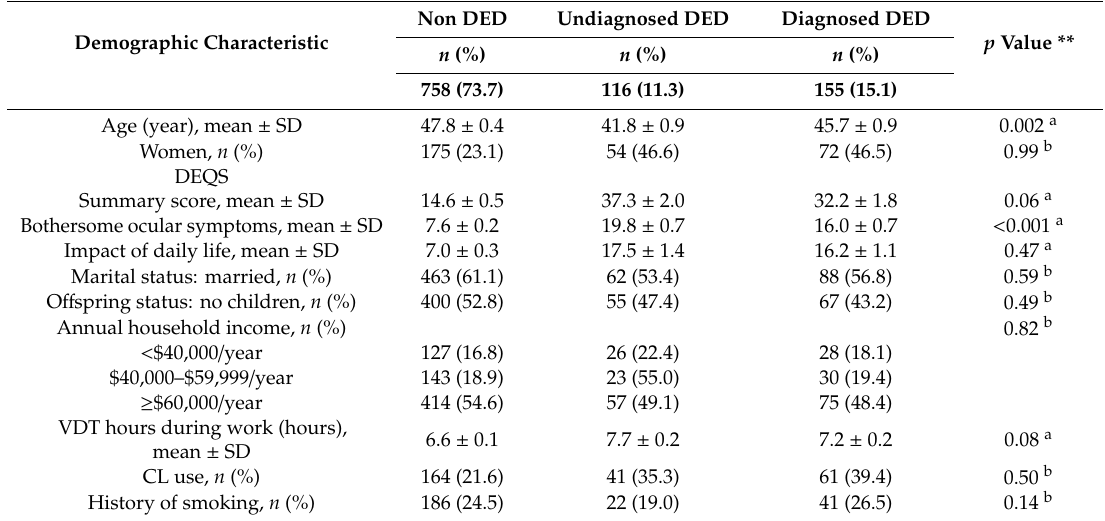
Table 2. The distribution of the study population among dry eye categories. Demographic characteristic